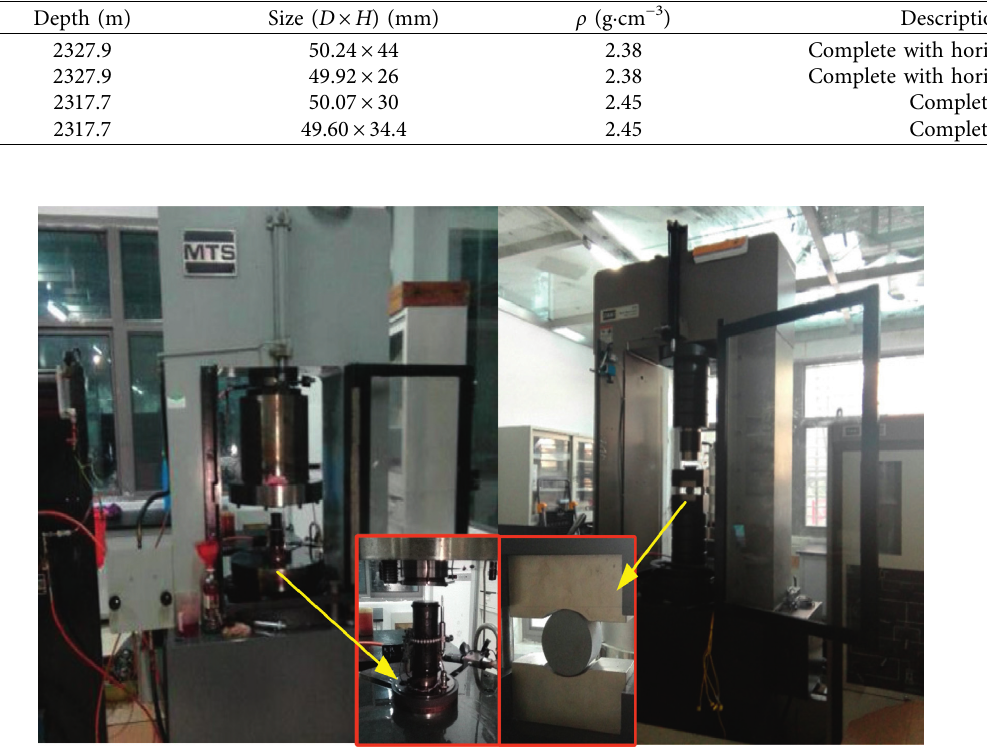
Figure 2: Testing machine used in the experiment of original rock.